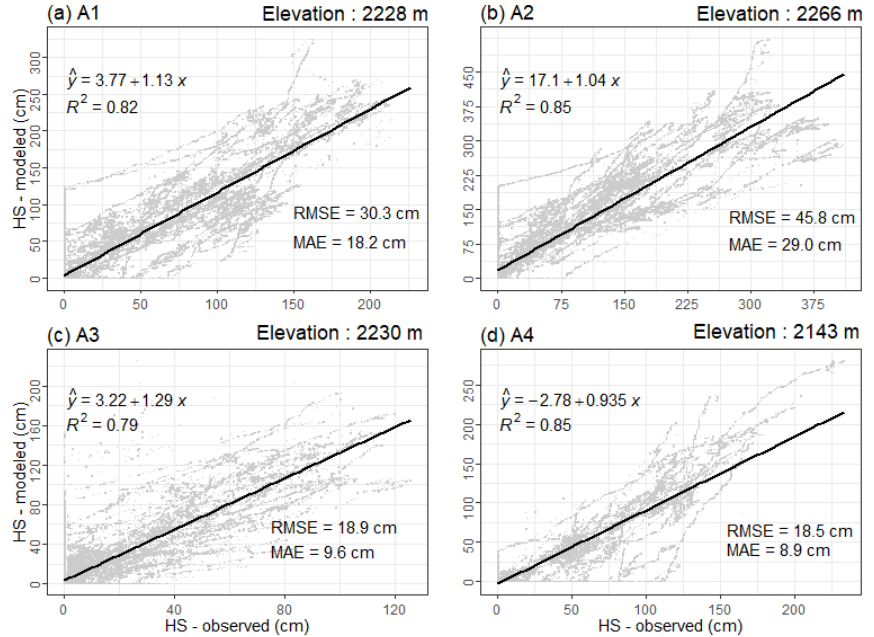
Figure 3. Regression analysis of observed ( x axis) and simulated ( y axis) HS